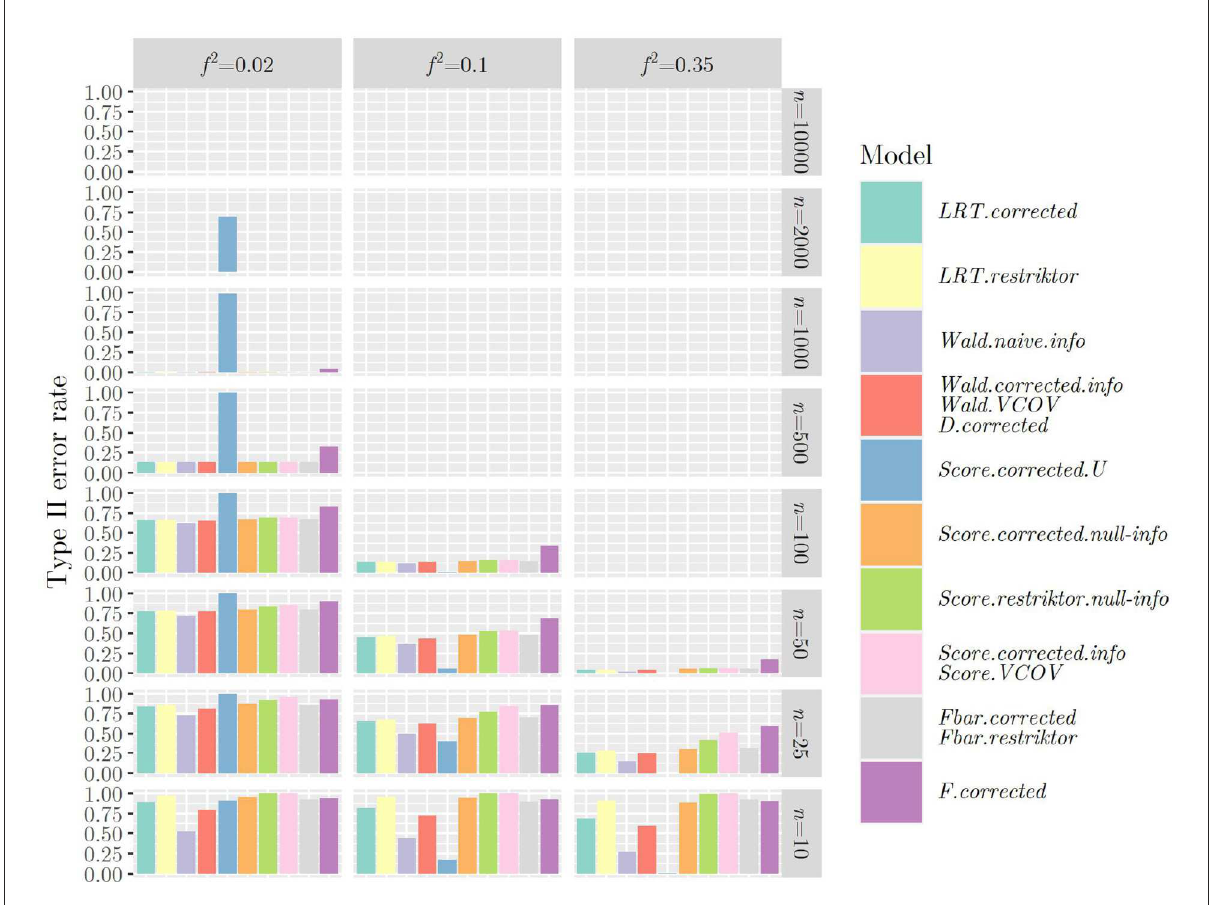
FIGURE2 Type II error rates when using R 2 and applying the test statistics as outlined in the referenced